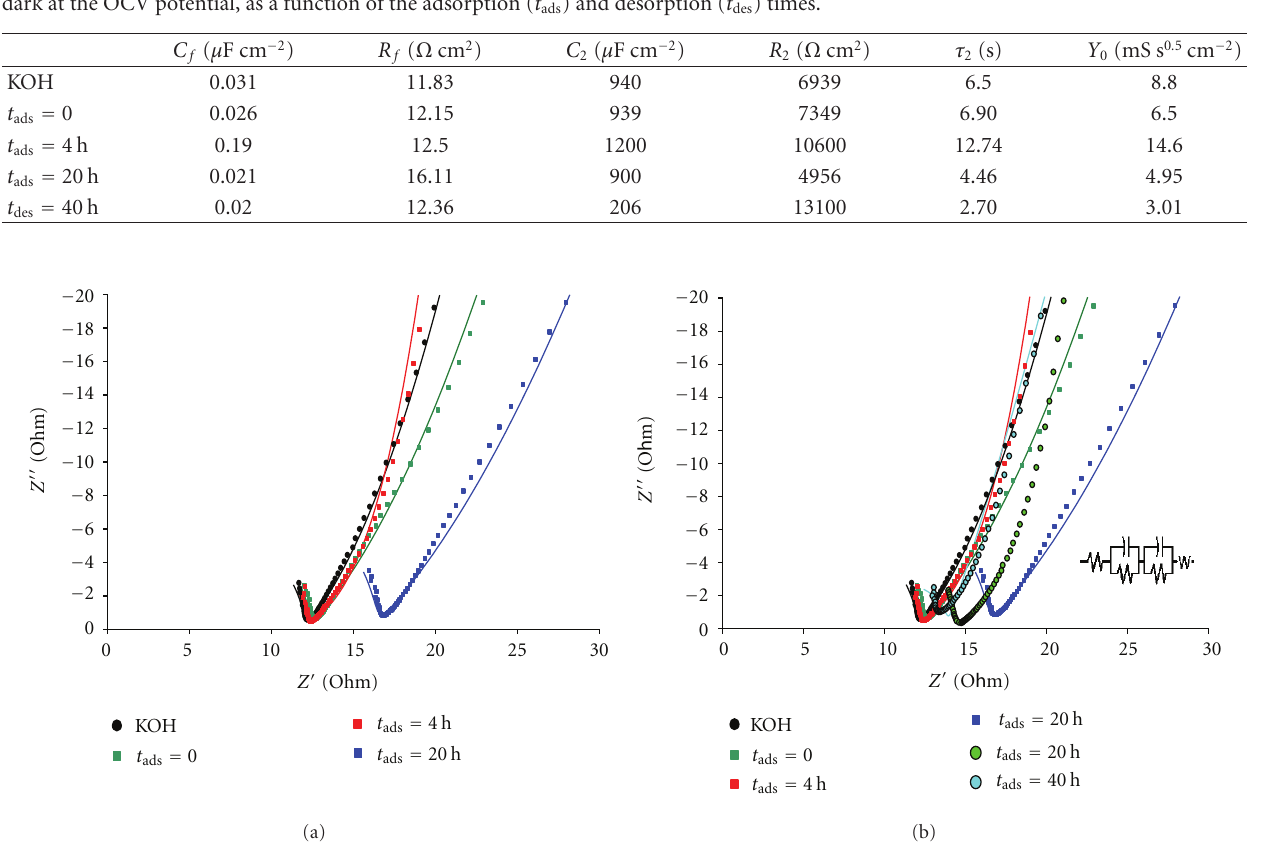
Figure 5: (a) E ff ect of G adsorption on the Nyquist plots; each curve is obtained after the sample was maintained in contact with (G) = 0 . 1 M alkaline solution for increasing intervals of time t . Black symbols refer to test performed in the solvent without G. (b) E ff ect of G desorption. Solid lines refer to the model